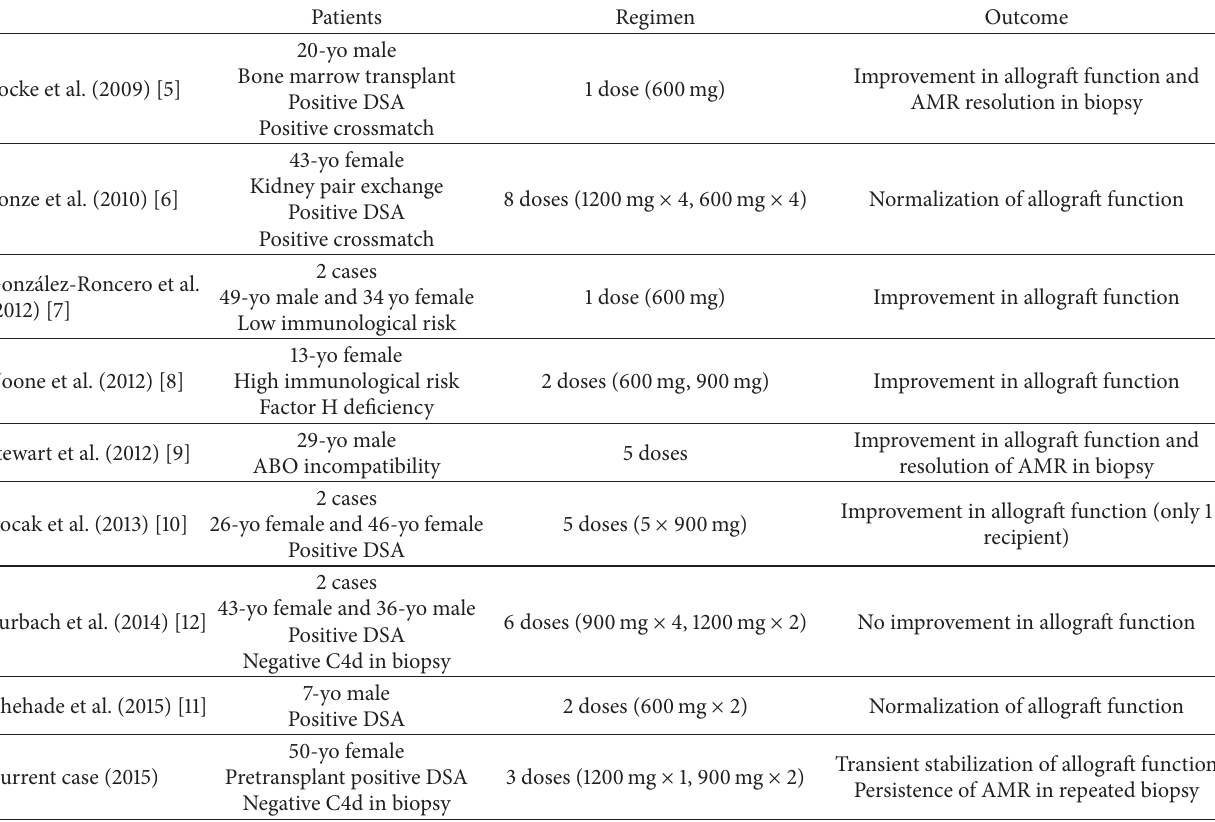
Table 1: Cases of antibody-mediated rejection treated with